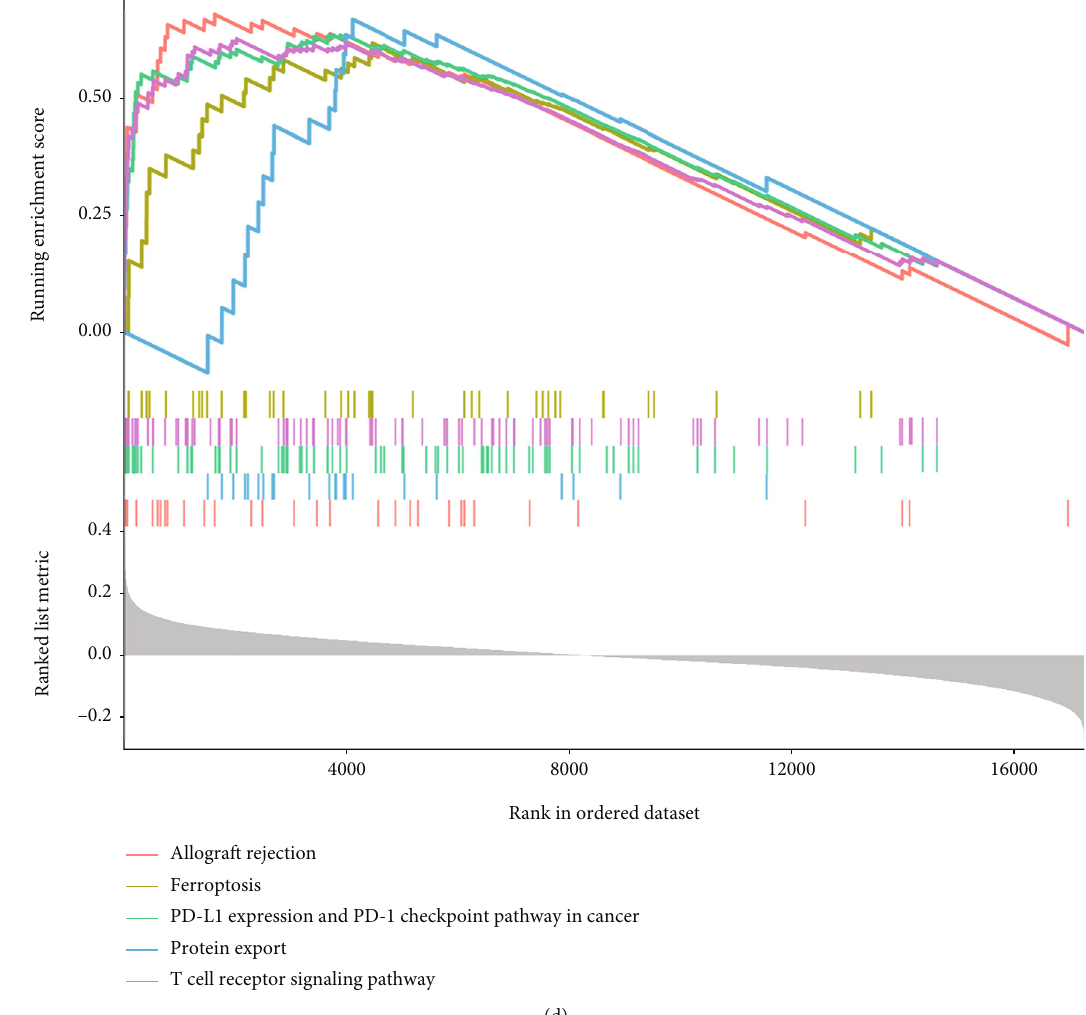
Figure 4: (a) Immune subsets were signi fi cantly associated with HLA family genes. Among 24 HLA-related genes, only fi ve genes, HLA-G, HLA-DRB6, HLA-DPB2, HLA-DOB, and HLA-B, were not signi fi cant in the distribution of immune subsets. The remaining HLA family members were statistically distributed in the immune subgroups ( p < 0 : 06 ). (b) Immune subtypes were signi fi cantly associated with immune cell in fi ltration. Monocytes, M1 macrophages, M2 macrophages, CD8 + T cells, CD4 + memory-activated T cells, and follicular helper T cells were substantially high up in the Immunity_H group than in the Immunity_M groups and Immunity_L. The results of B cells naive, B cells memory, plasma cells, and CD4 + naive T cells in Immunity_L were considerably more excellent than those in Immunity_M and Immunity_ H. (c and d) GO and KEGG analysis di ff erential gene enrichment analysis of Immunity_H and Immunity_L “ ∗∗ , ” and “ ∗∗∗ ” represent that the di ff erence between the two experimental groups was statistically signi fi cant ( p < 0 : 05 , p < 0